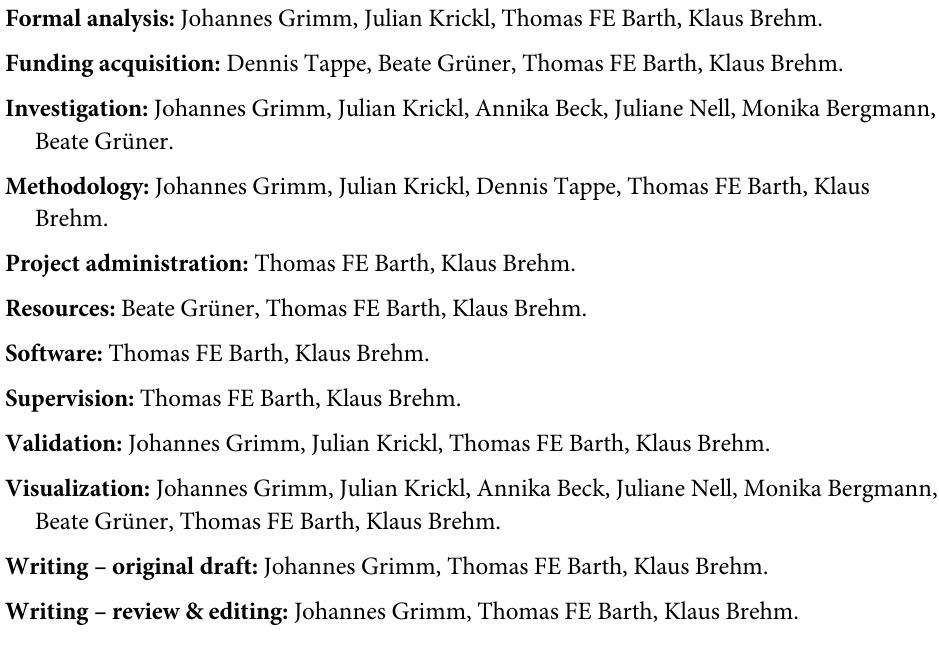
with nuclei (bar represents 10 mm). Shown below are cell counts per mm 3 germinal layer in five independ experiments (SD, standard deviation). S3 Fig. Comparison of primer-set 1 and primer-set 3 in detecting E . multilocularis DNA in experimental and clinical samples. A) Agarose gel showing the results of PCR amplification of primer-set 3 on isolated E . multilocularis cells mixed with 25 mg liver tissue of mongolian jirds. M, marker lane; 1, no Echinococcus cells; 2, 10 2 cells; 3, 10 3 cells; 4, 10 4 cells; 5, 10 5 cells; 6, 10 6 cells. Marker fragment sizes are indicated to the left (in bp). B) PCR results for selected FFPE samples. Indicated are the patient number ( � as listed in S1 Table), the age of the material, the sample group, and the PCR results for primer-set 1 (PCR protocol A) and primer-set 3 (PCR protocol C). + indicates positive result,—indicates negative